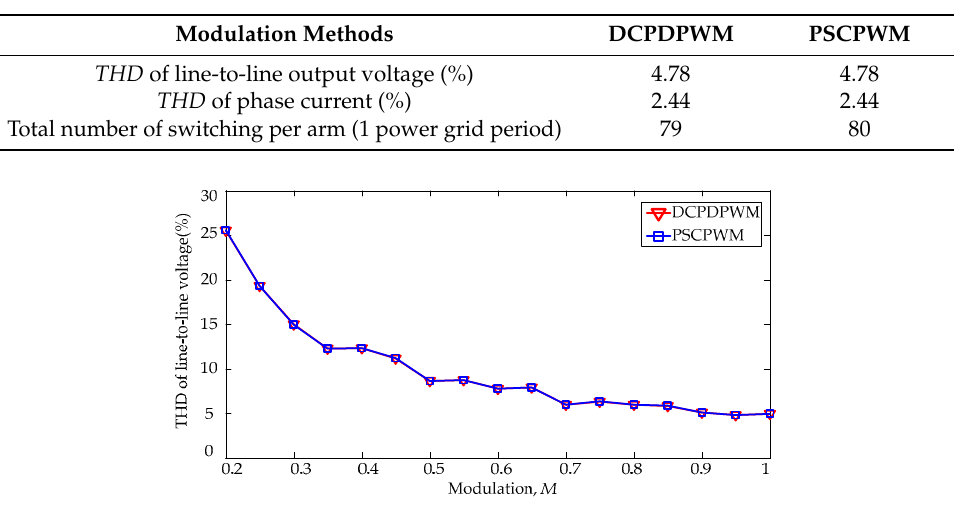
Table 3. Comparison of simulation results between DCPDPWM and PSCPWM method with the output voltage harmonics minimization scheme.